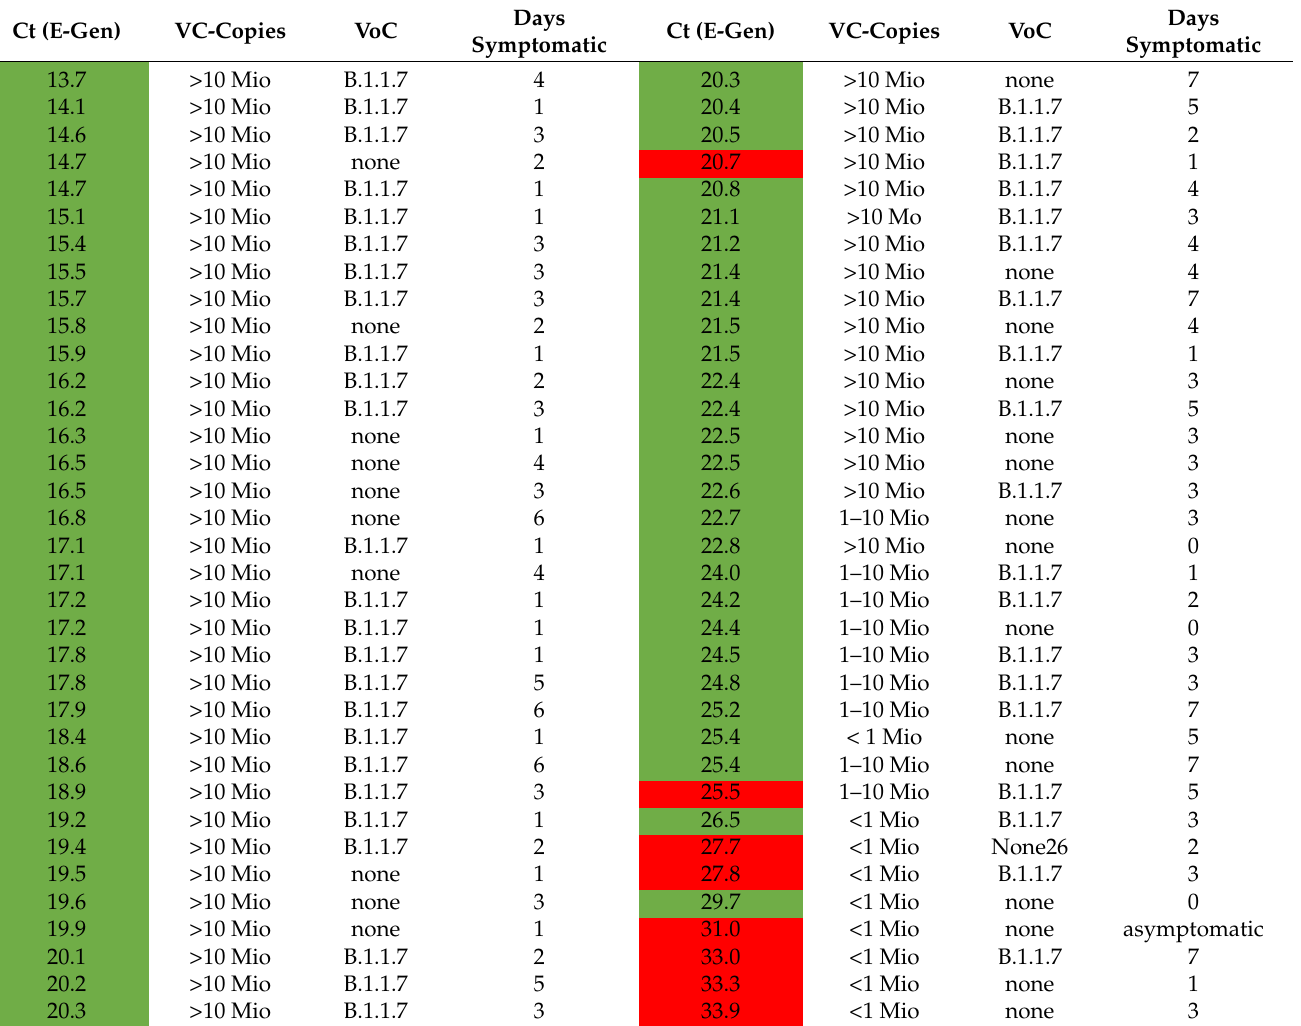
Table 2. Antigen-detecting rapid diagnostic test (RDT) results with a supervised self-collected anterior nasal swab in 70 RNA positive patients from combined oropharyngeal/nasopharyngeal swab. Abbreviations: Ct—cycle threshold, VC—Viral concentration, VoC—Variant of concern. Green—Positive antigen-detecting rapid diagnostic test. Red—Negative antigen-detecting rapid diagnostic